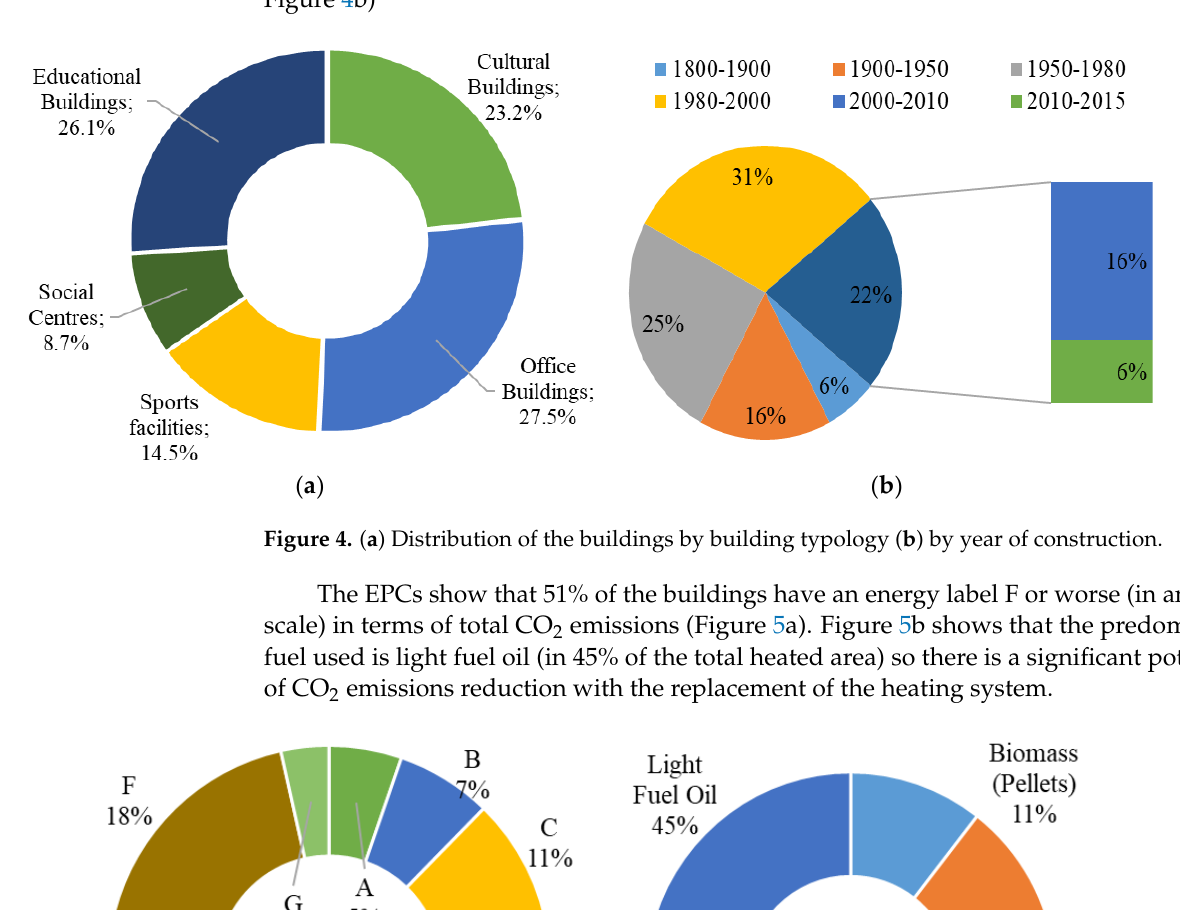
( b ) Figure 6. ( a ) Distribution of the EPC energy label regarding the heating demand and ( b ) the cooling demand.